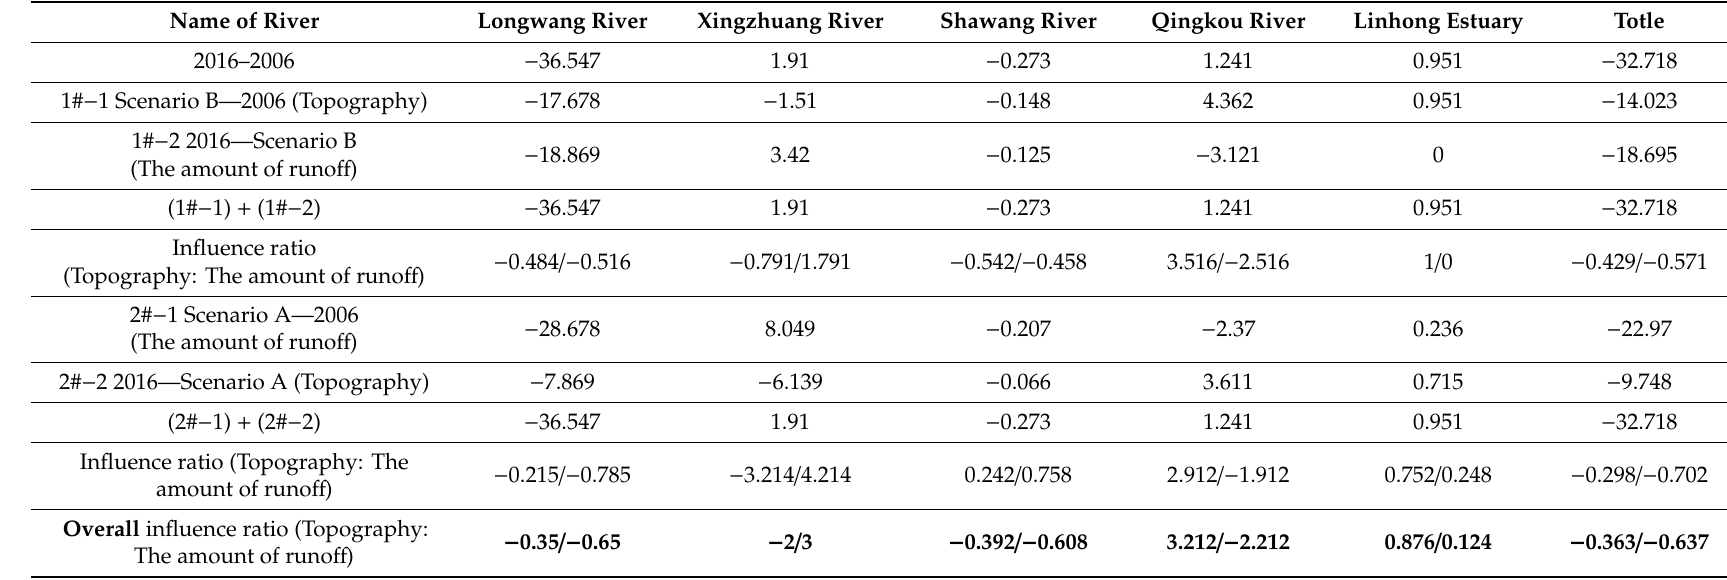
Table 8. The comparative analysis of di ff erent